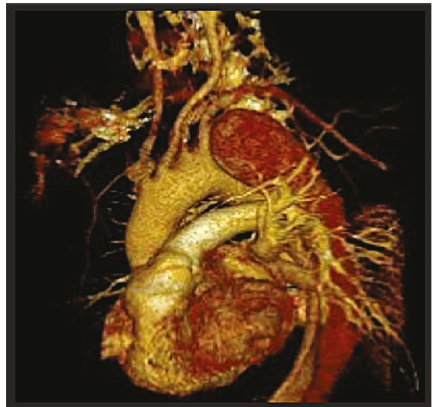
Figure 2: Preoperative virtual 3D CT angiogram of the aorta showing the separate origin of the left vertebral artery from the aortic arch.